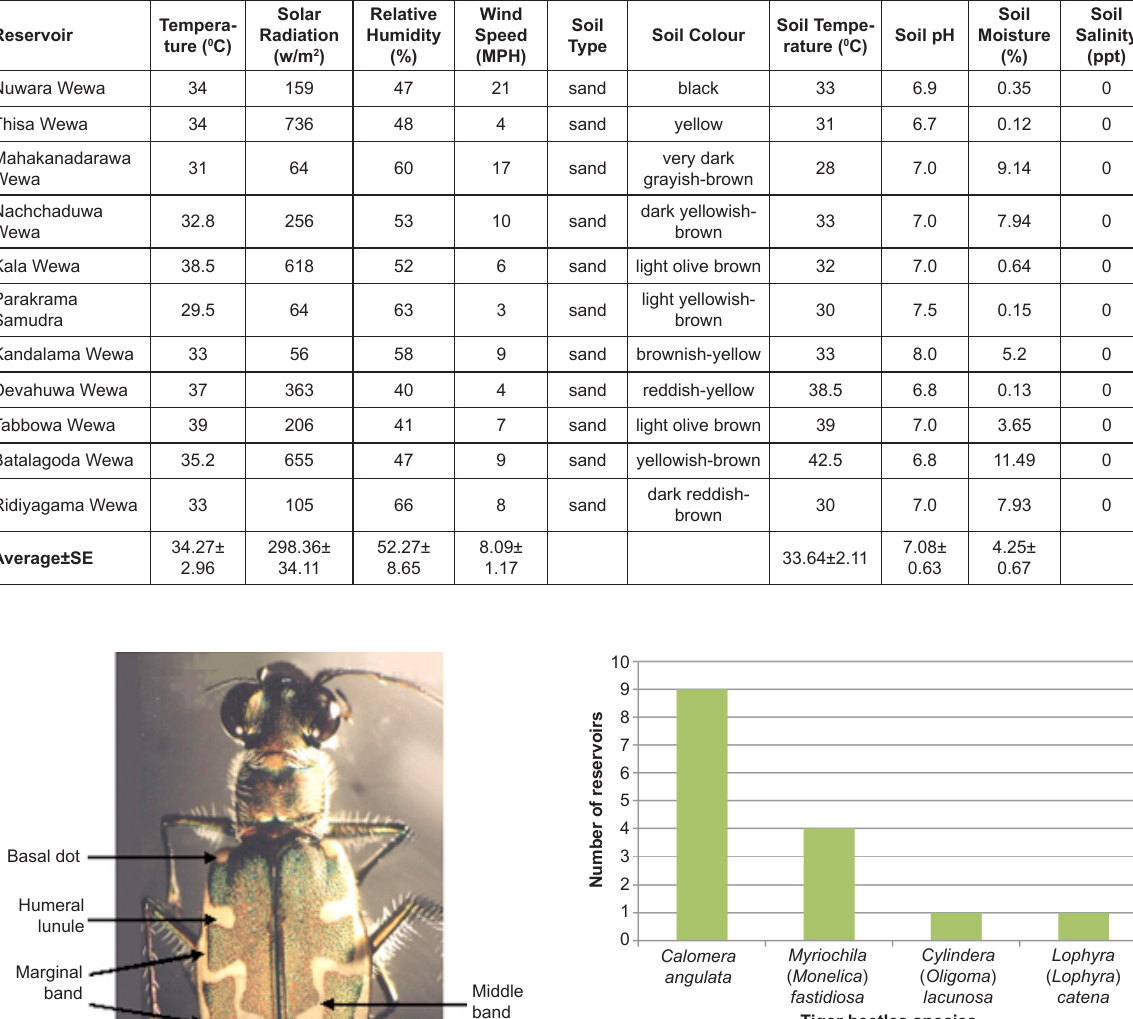
Table 3. Climate and soil parameters of the reservoir habitats of tiger beetles recorded at the time of collection